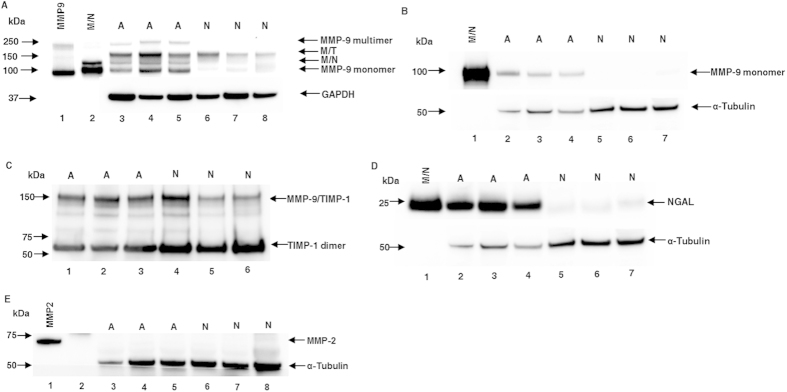
Western blot analysis of MMP-9, TIMP-1, NGAL and MMP-2 in AVMs and normal tissues.(A) Under non-reducing conditions, rhMMP-9 (lane 1) and purified neutrophil MMP-9/NGAL complex (lane 2) were used as positive controls; lanes 3–5, AVMs; lanes 6–8, normal tissues. (B) Under reducing conditions, purified neutrophil MMP-9/NGAL complex (lane 1) was used as a positive control (MMP-9/NGAL complex will break into MMP-9 and NGAL when running under reducing condition); lanes 2–4, AVMs; lanes 5–7, normal tissues. (C) Under non-reducing conditions, the blot was probed with anti-TIMP-1 antibody, lanes 1–3, AVMs; lanes 4–6, normal tissues. (D) Under reducing conditions, purified neutrophil MMP-9/NGAL complex was loaded as a positive control (lane 1); lanes 2–4, AVMs; lanes 5–7, normal tissues. (E) Under reducing conditions, rhMMP-2 was loaded as a positive control (lane 1); lanes 3–5, AVMs; lanes 6–8, normal tissues. A, AVM; N, normal tissue; M/T, MMP-9/TIMP-1 complex; M/N, MMP-9/NGAL complex.